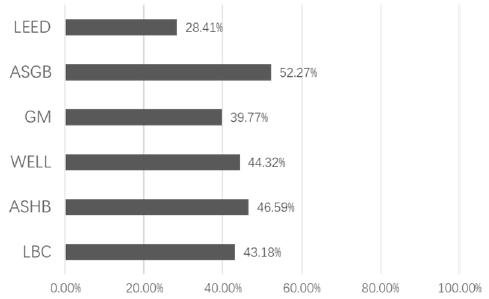
Figure 3. Inclusion degree of six GBRSs. (Source: by the author).